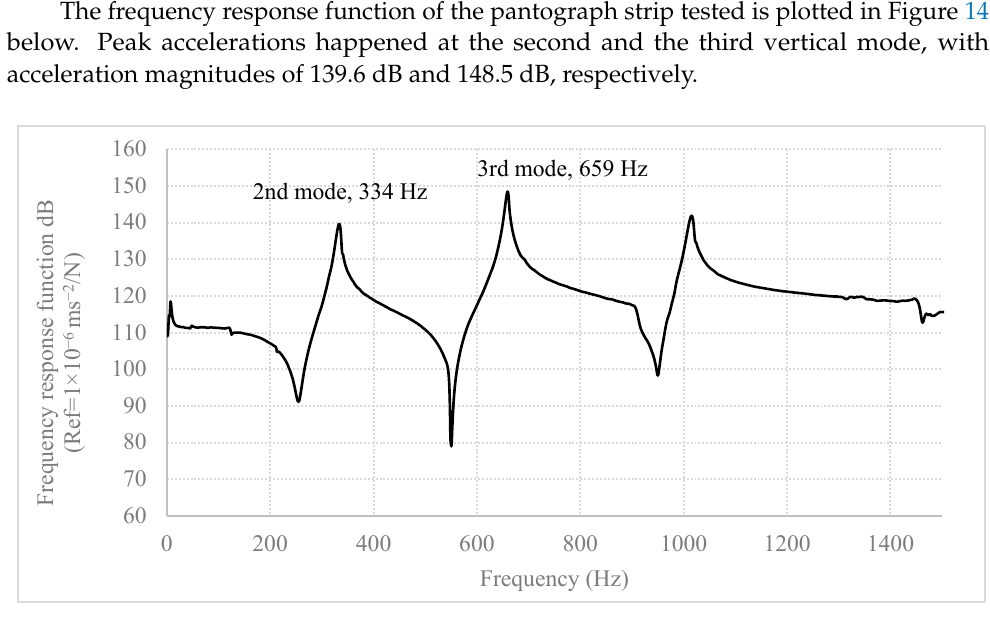
Figure 14. Frequency response function of the pantograph strip.